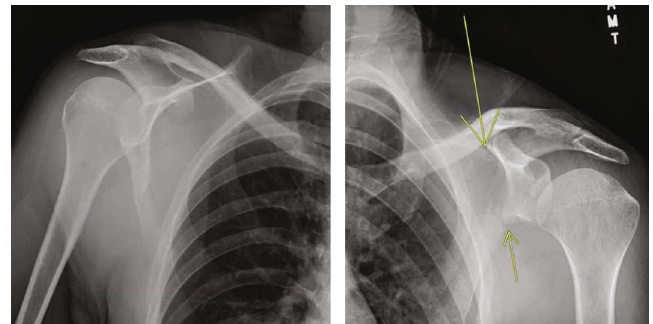
Figure 1: Plain fi lm radiographs of the right shoulder with no obvious right bony abnormalities noted. Left-sided scapular body fracture identi fi ed with intact glenohumeral joint.